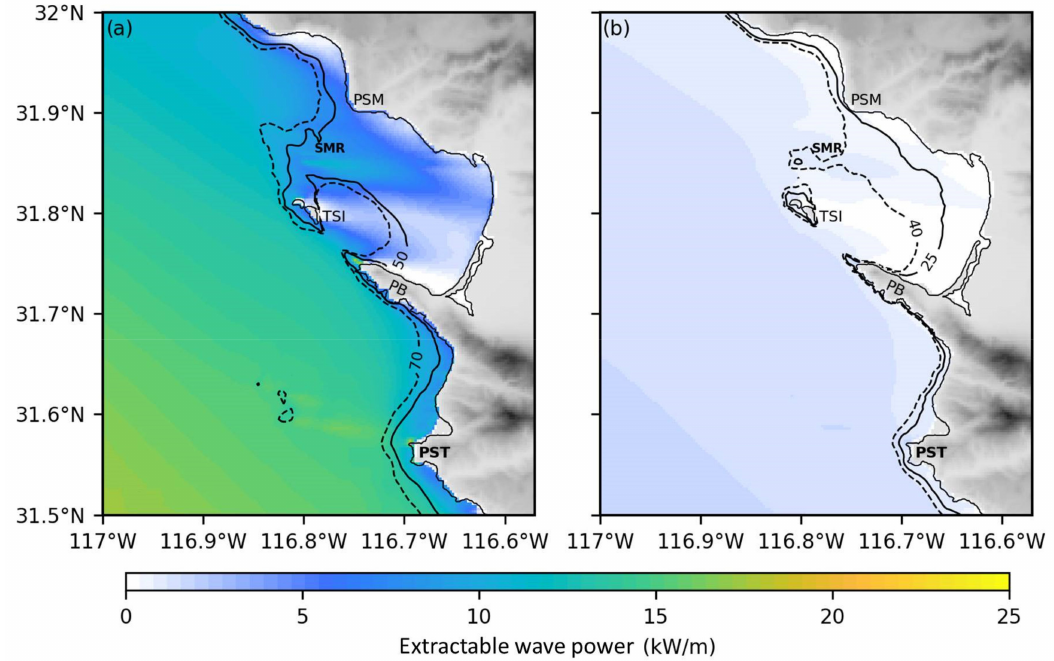
Figure 7. Mean efficiency of Pelamis ( a ) and WaveDragon ( b ), in terms of the wave power extracted by their respective dimensional widths. Punta Santo Tomas (PST) and San Miguel Reef (SMR) sites are indicated in bold. The solid and dashed lines represent isobaths in meters; the area between isobaths is the area with the optimal operating depth range for each WEC.